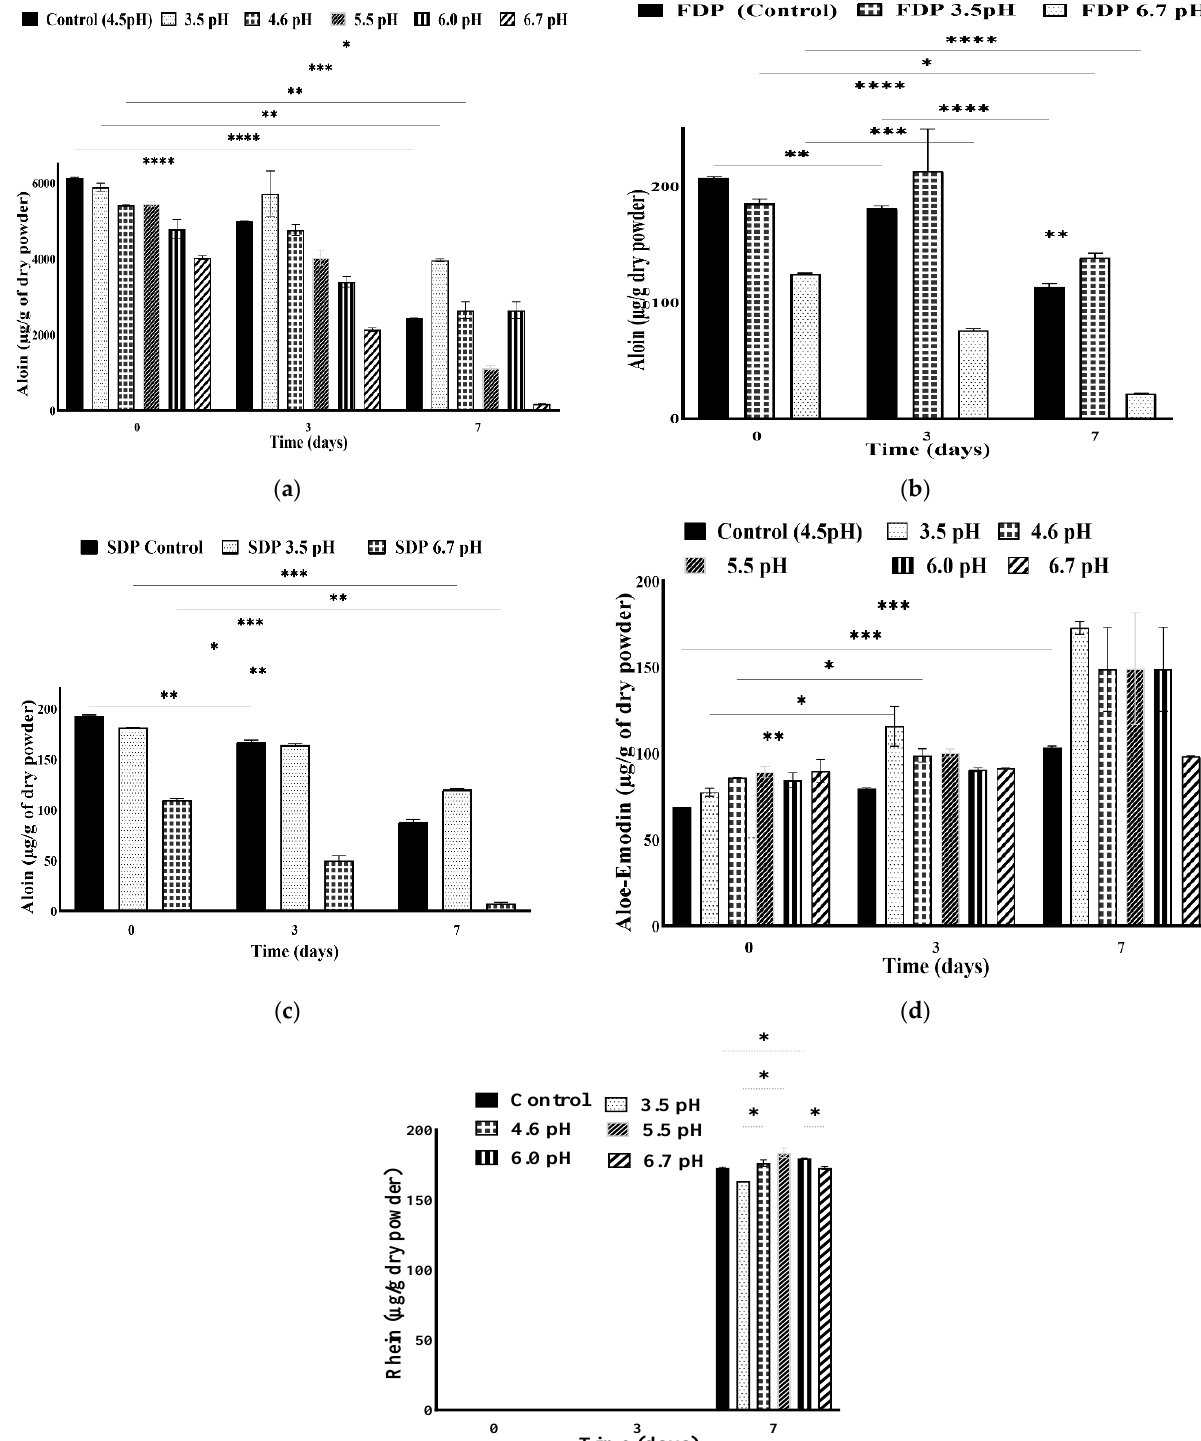
Figure 4. Plots of aloin in whole-leaf Aloe vera gel ( a ), aloin in freeze-dried powder of Aloe vera ( b ), aloin in spray-dried powder ( c ) of Aloe vera and plots of aloe-emodin ( d ) and rhein ( e ) in whole-leaf Aloe vera gel, vs. time under various pH conditions. (Values are from triplicates; the mean and standard deviation are shown. Values significantly different from control to various pH treatments in a two-way ANOVA with Dunnett’s test analysis are indicated with asterisks: * p < 0.01, ** p < 0.001, *** p < 0.0003, **** p <